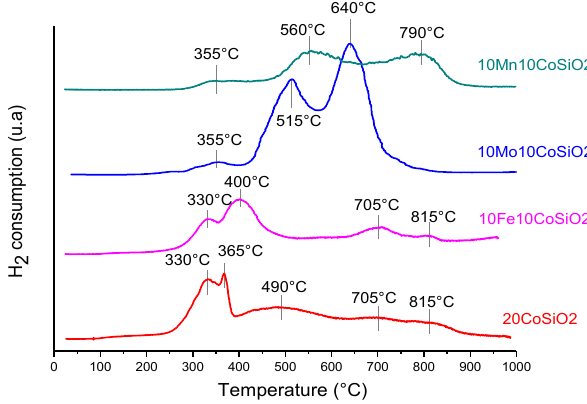
Figure 3. TPR profiles of the mono and bimetallic Co-based samples.